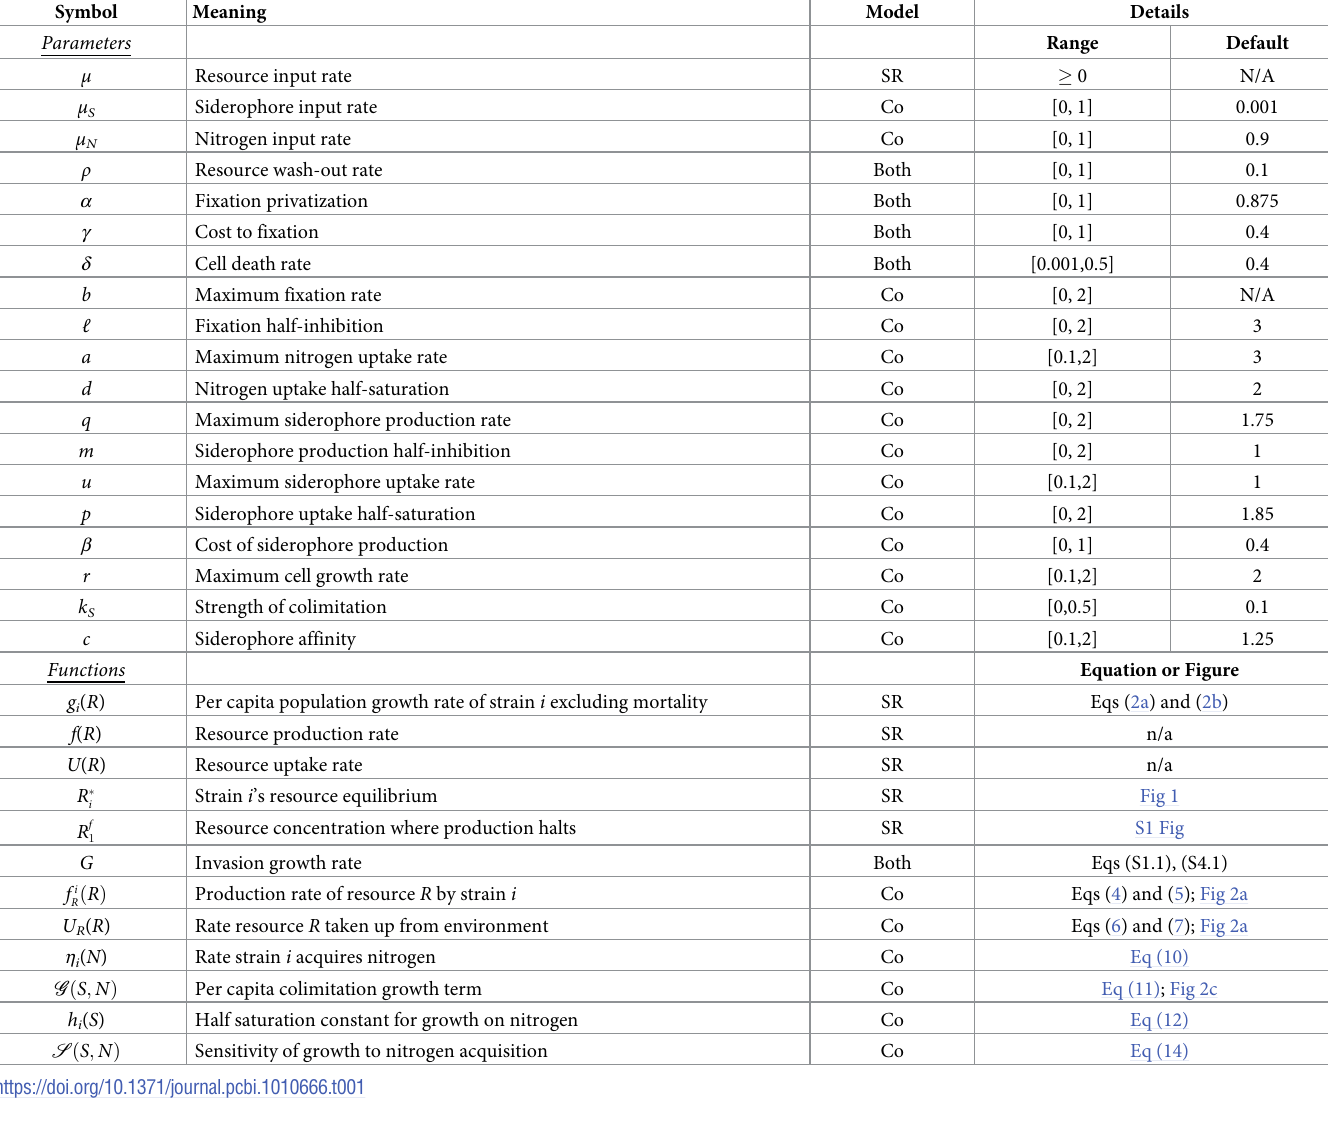
Table 1. Summary of model parameters and functions for both models (SR = single resource model, Co = colimitation model). Numerical exploration of the colimita- tion model was done with randomly generated parameter combinations over the ranges given that satisfied inequality Eq (S2.2) (about 50% of all combinations). Default values used for adaptive dynamics are given in the final